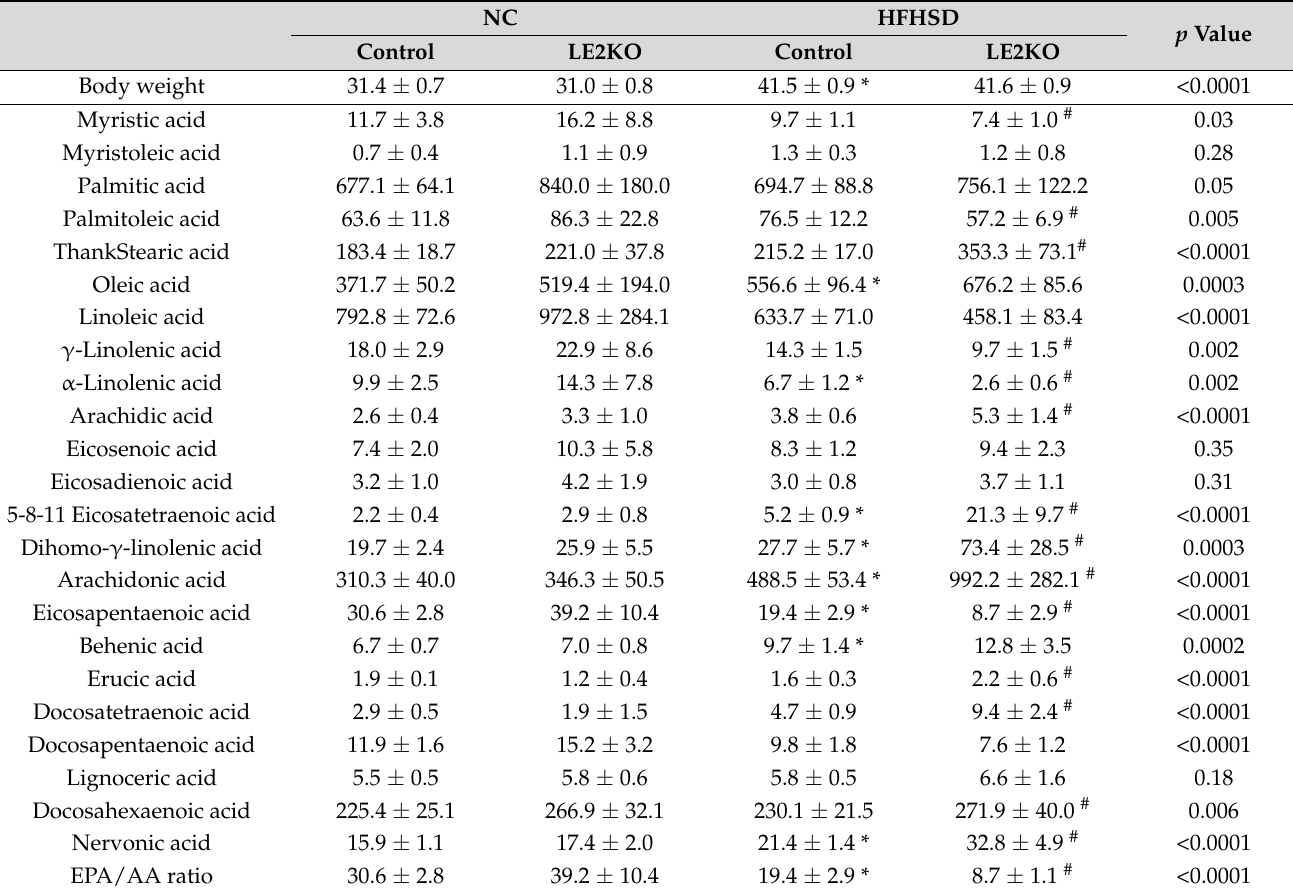
Table 1. Serum Fatty Acid